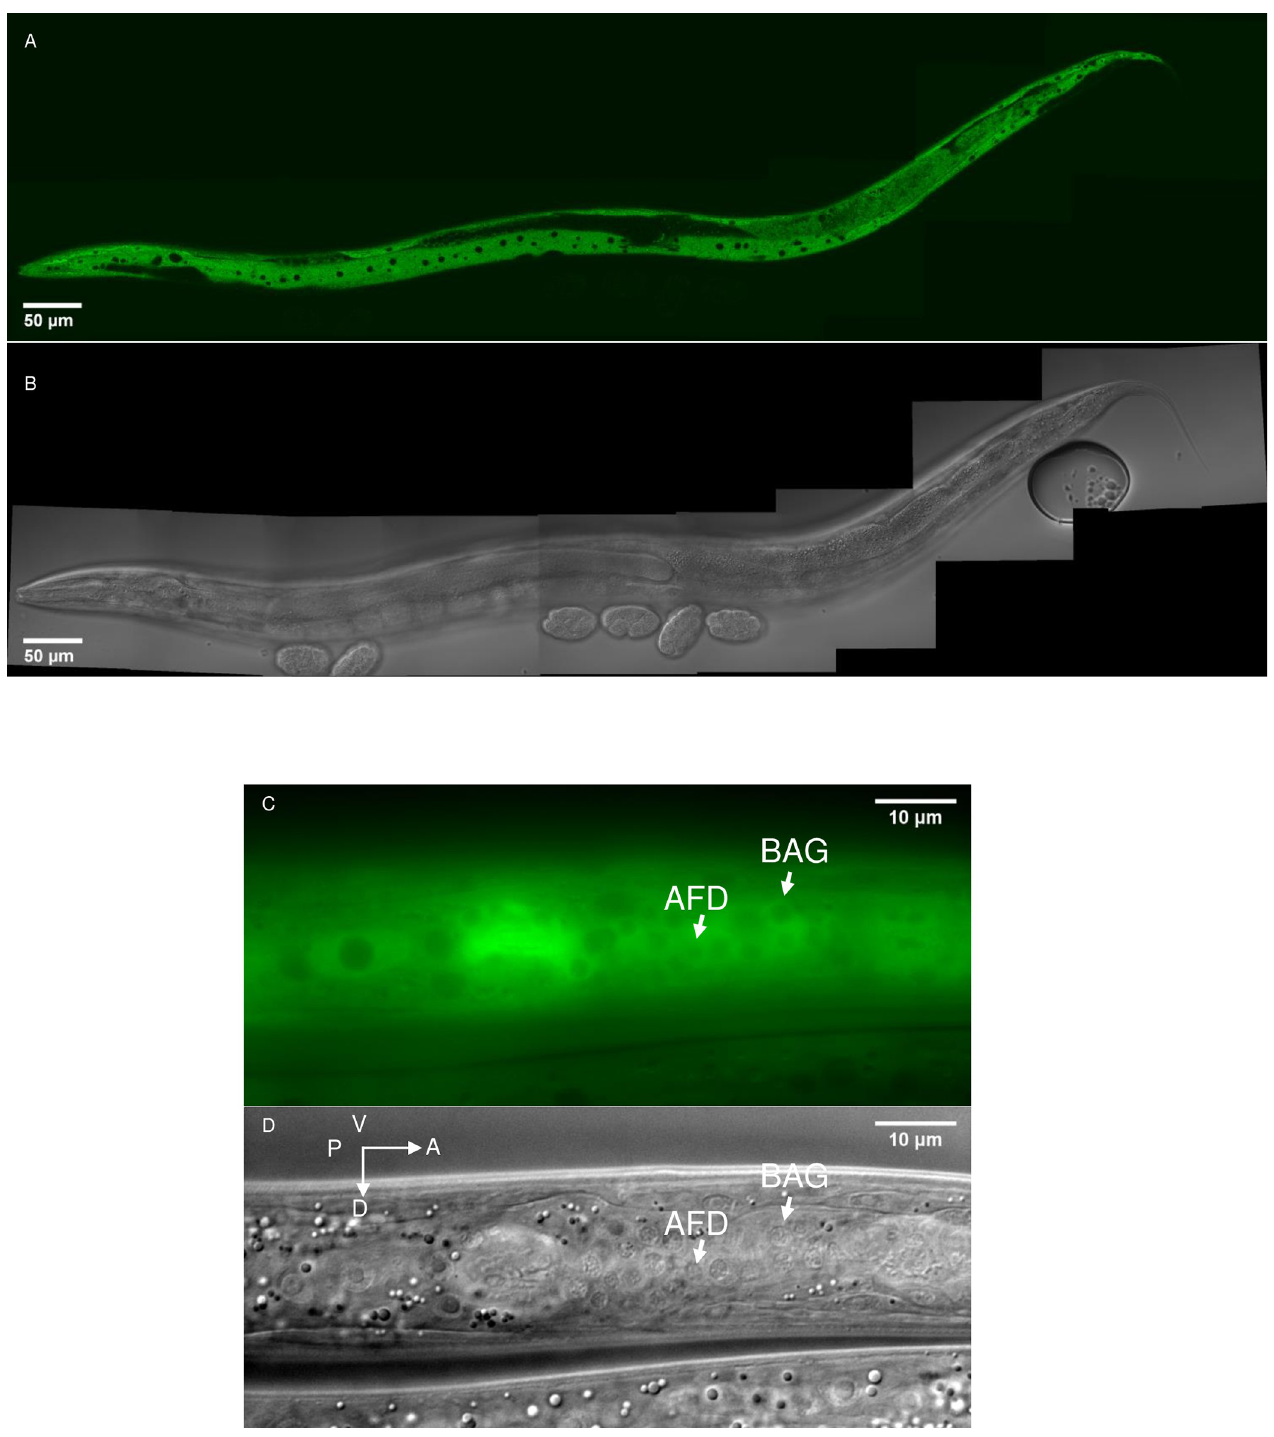
Fig 2. ola-1 expression. ola-1(nj80); njEx1668[ola-1p :: ola-1 :: GFP] animals were subjected to microscopic analysis. GFP fluorescence and DIC images for the whole-body (A) and head region (B).